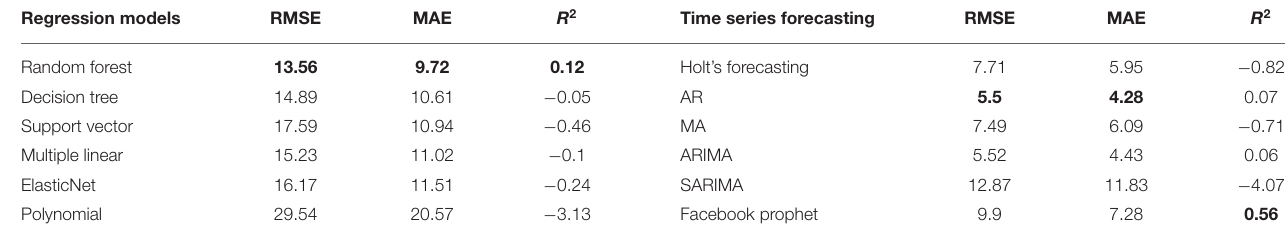
TABLE 6 | Performance metrics comparison table for